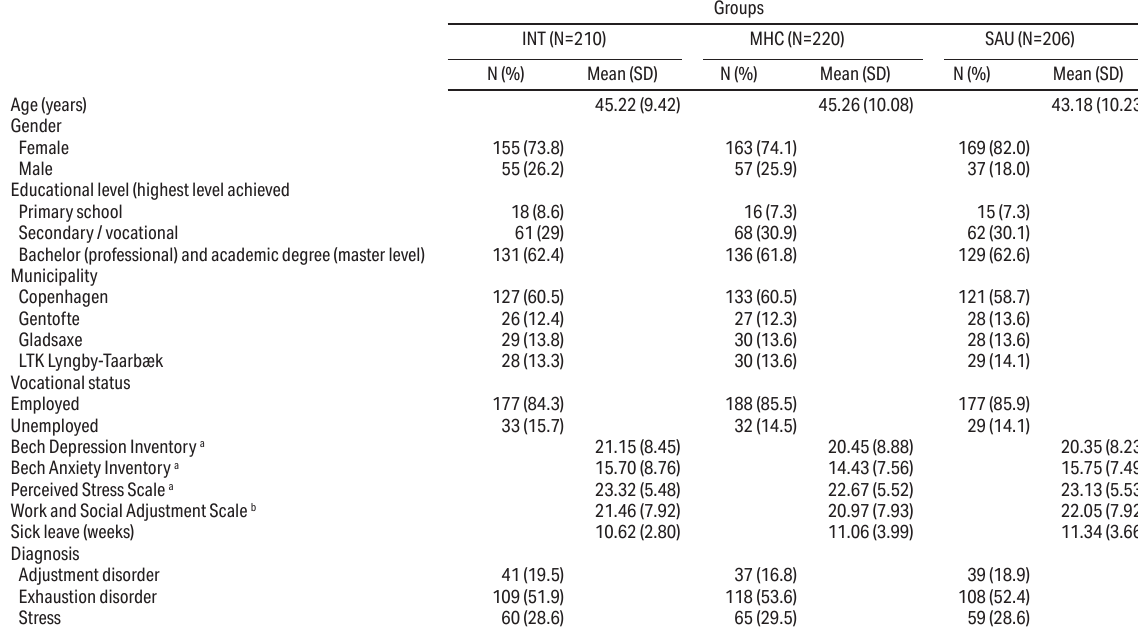
Table 1. Baseline characteristics. [SD=standard deviation; MHC=mental healthcare; SAU=service as usual; INT=integrated